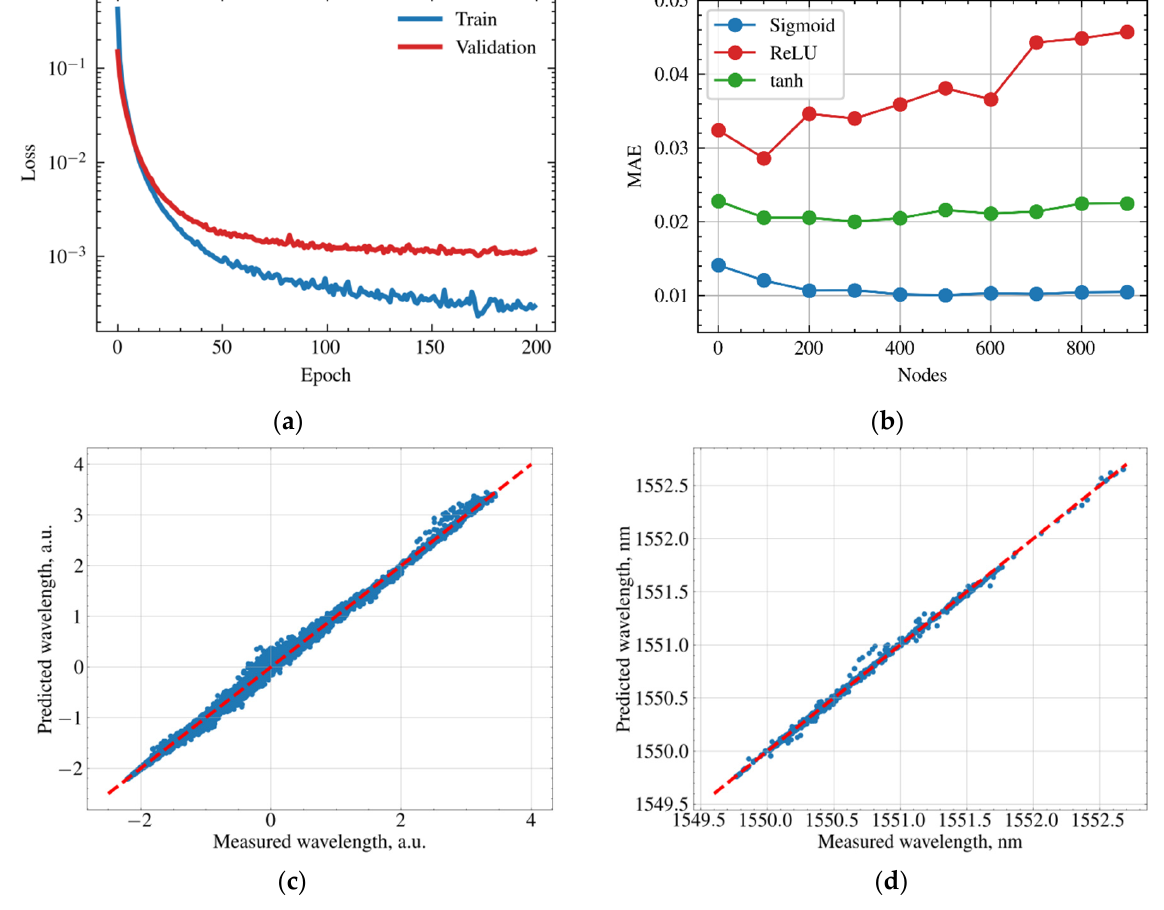
Figure 8. Performance of the FCNN. ( a ) Learning curve of the model on training dataset and evolution of the loss function of validation dataset. ( b ) Mean absolute error of FCNN for different activation functions and different number of nodes of the hidden layer. ( c ) Predicted reflectance peak positions of the FBGs of the sparse sensors against measured values at normalized scales. ( d ) Predicted positions of the reflectance peak for single FBG of sparse sensor against measured value.